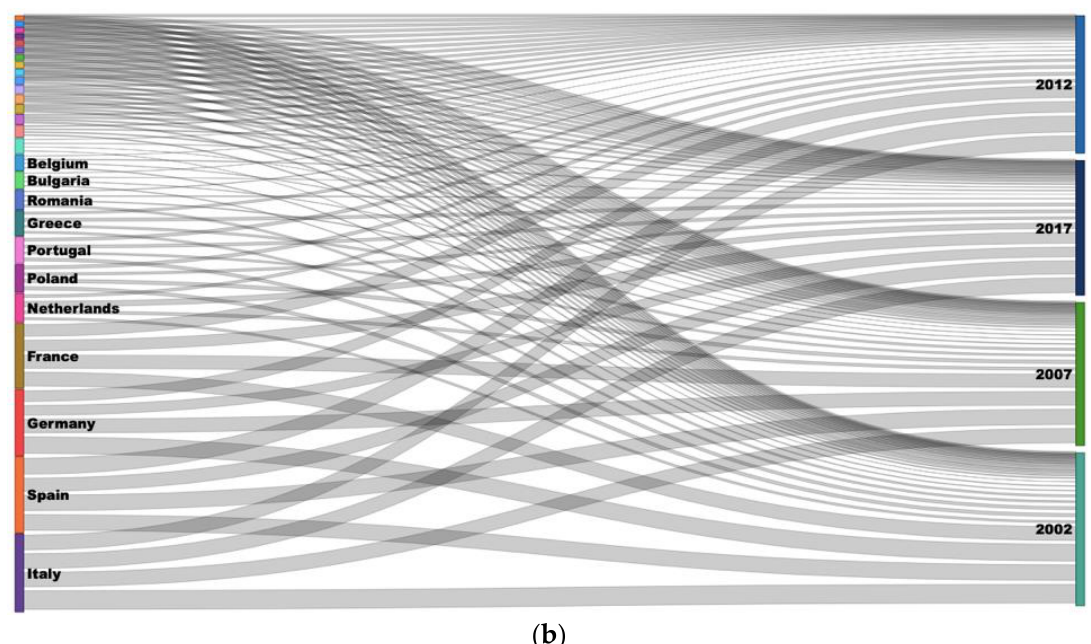
Figure 3. Water stress and total water withdrawal of EU countries. Note: ( a ) water stress, ( b ) total water withdrawal. Source: built based on AQUASTAT data [4].